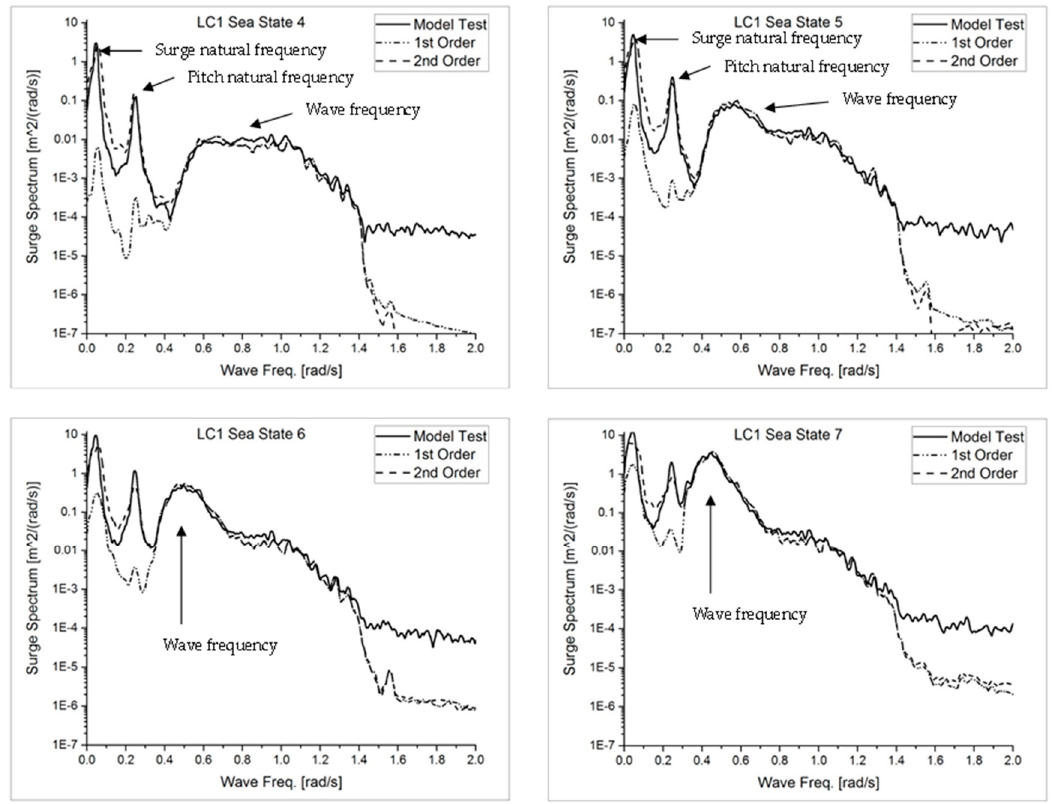
Figure 10. Surge spectrums of four sea states in LC1 (only irregular waves).